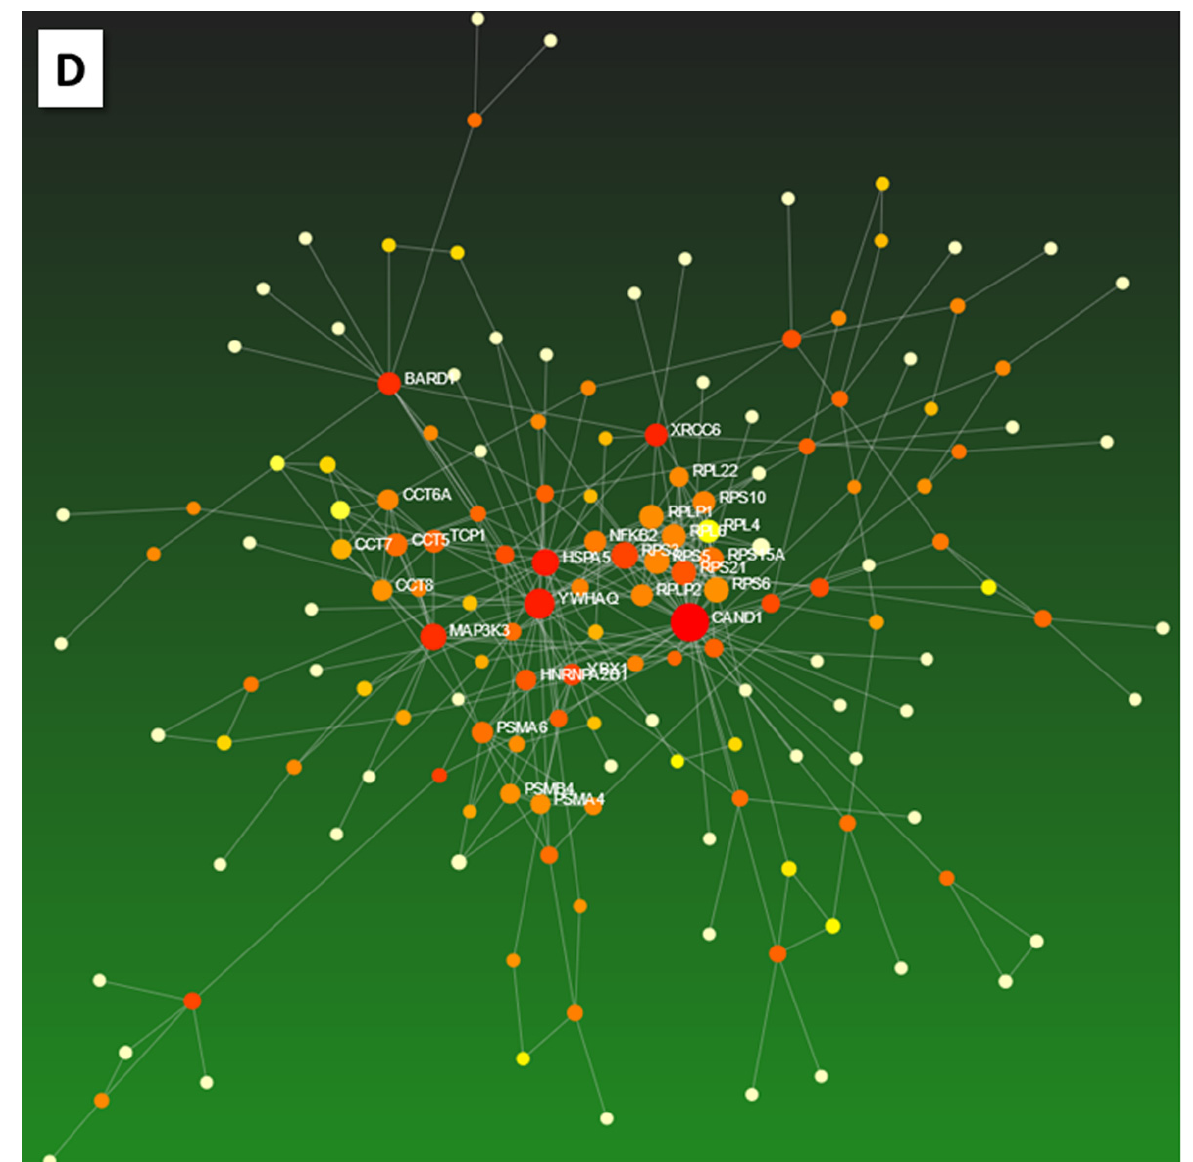
Figure 3. Comparison of GC vs. NGM shortlisted proteins. ( A ) Heatmap (Spearman rank correlation). ( B ) PCA. ( C , D ) Zero-order networks of ( C ) up-, and ( D ) downregulated proteins. For details, see Supplementary Figures S6 and S7.